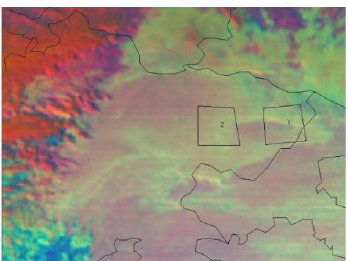
Figure 15. T-Re profiles at 14:53 LST (a: region 1; b: region2)